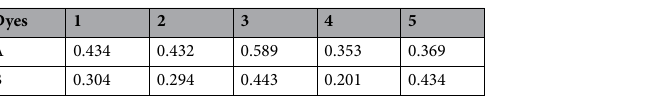
Table 4. The integral area obtained from the overlap between anchoring group and two surface Ti atoms for the studied dye adsorption